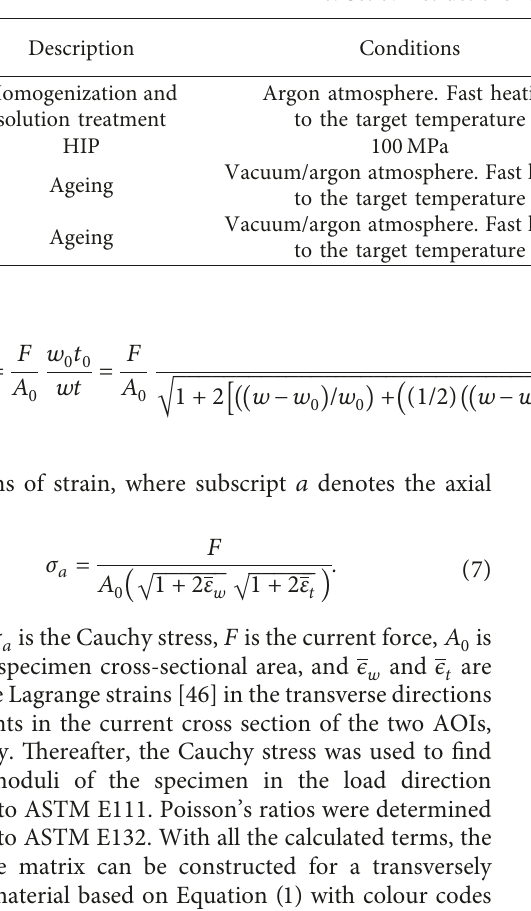
Table 6: Set 3: instructions for treatment (S + H +